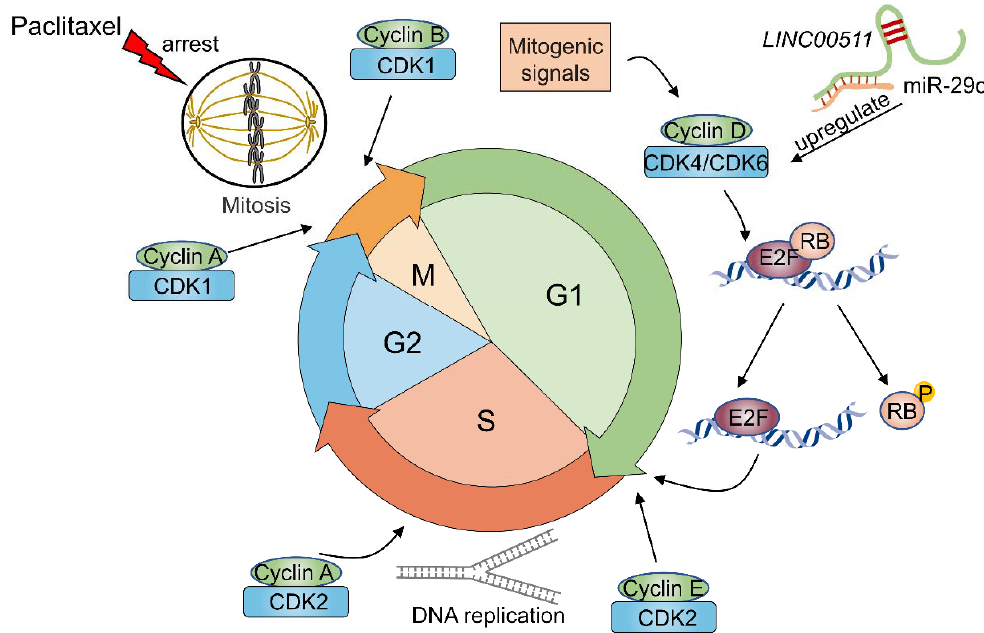
Figure 5. Cell cycle progression and CDKs ( LINC00511 is used as example for clarifying the mechanism). The cell cycle is divided into four distinct phases: G1 (postmitotic interphase), S phase (DNA